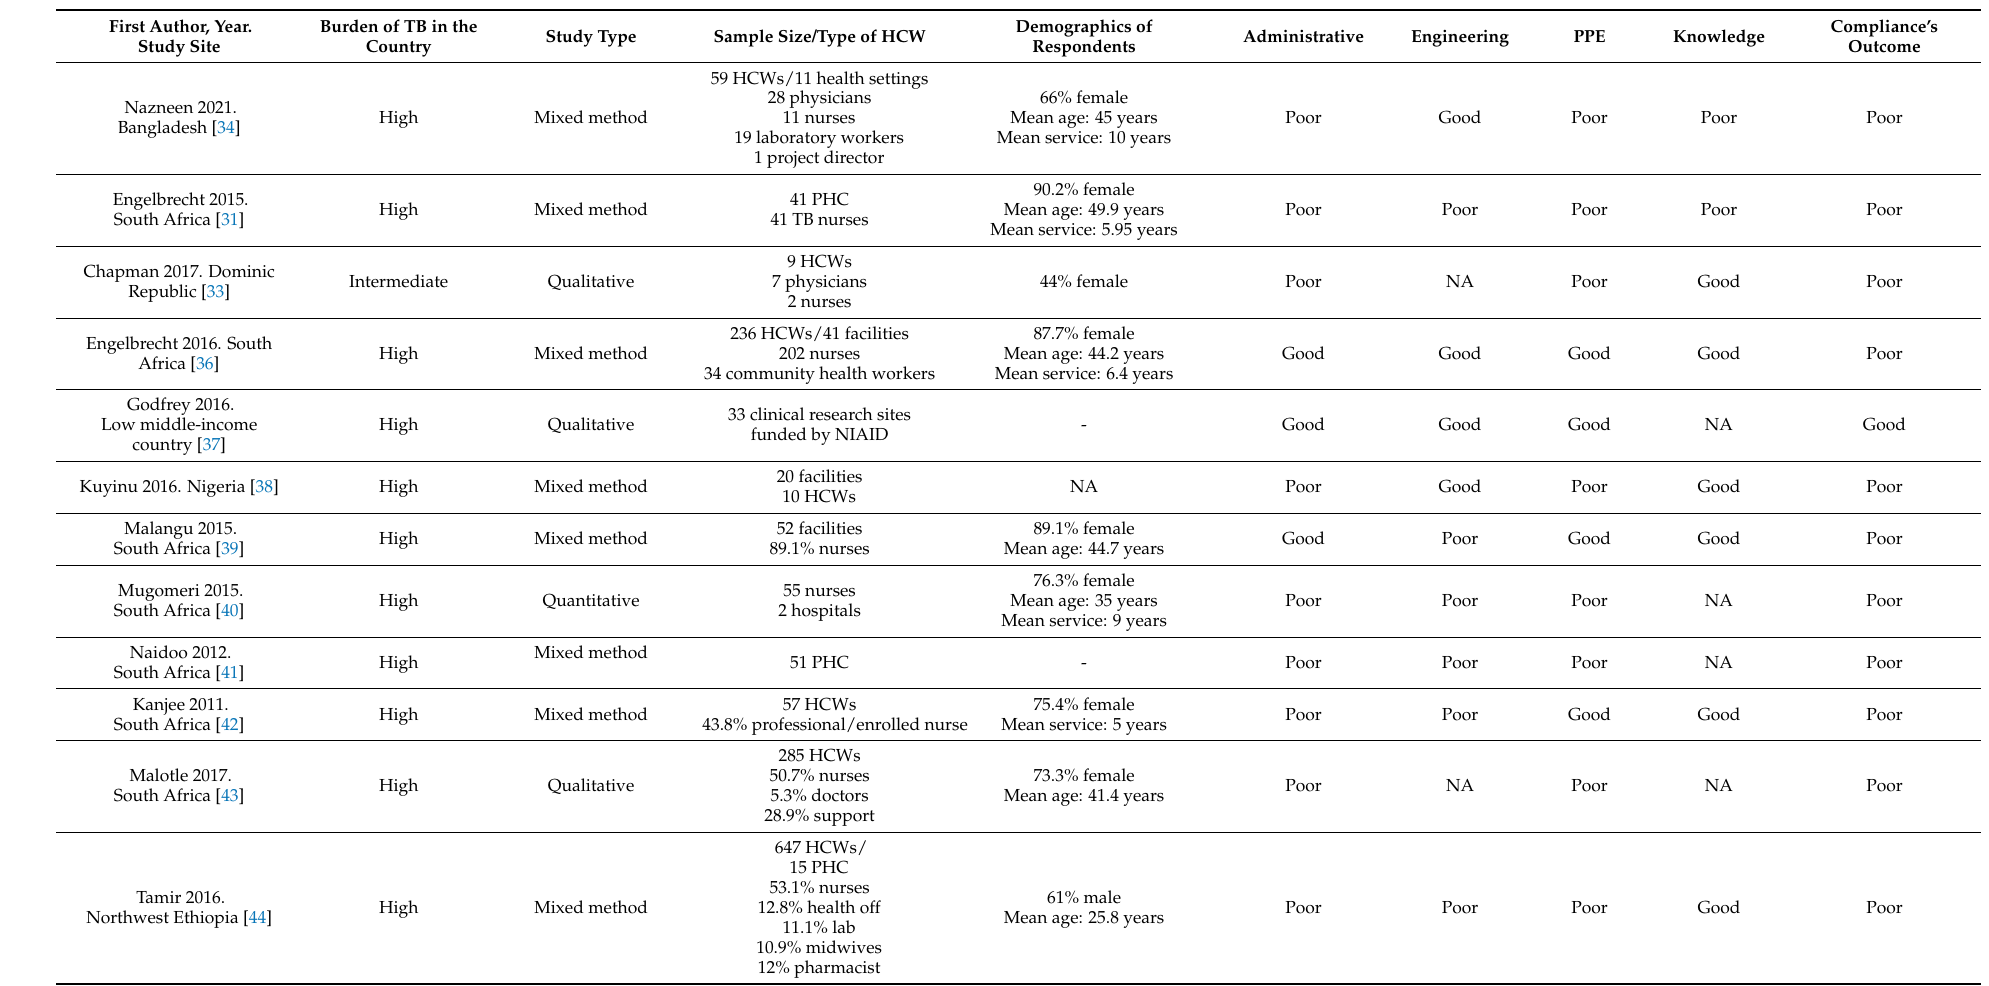
Table 6. Descriptive analysis of the